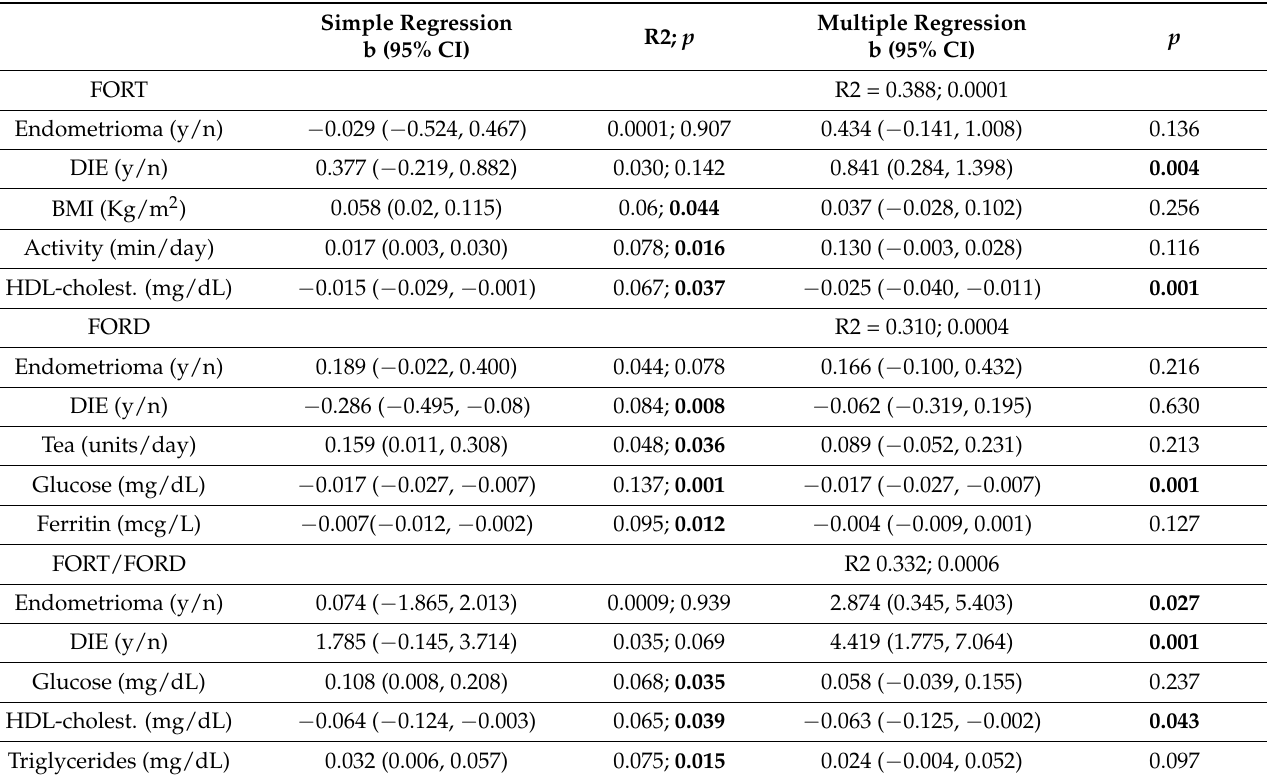
Table 3. Simple linear regression analysis and multiple linear regression analysis of factors signifi- cantly correlated with blood oxidant (FORT) and antioxidant activity (FORT) and FORT/FORD ratio in the examined women, of which 24 were without endometriosis, 26 were with endometrioma, and 26 were with